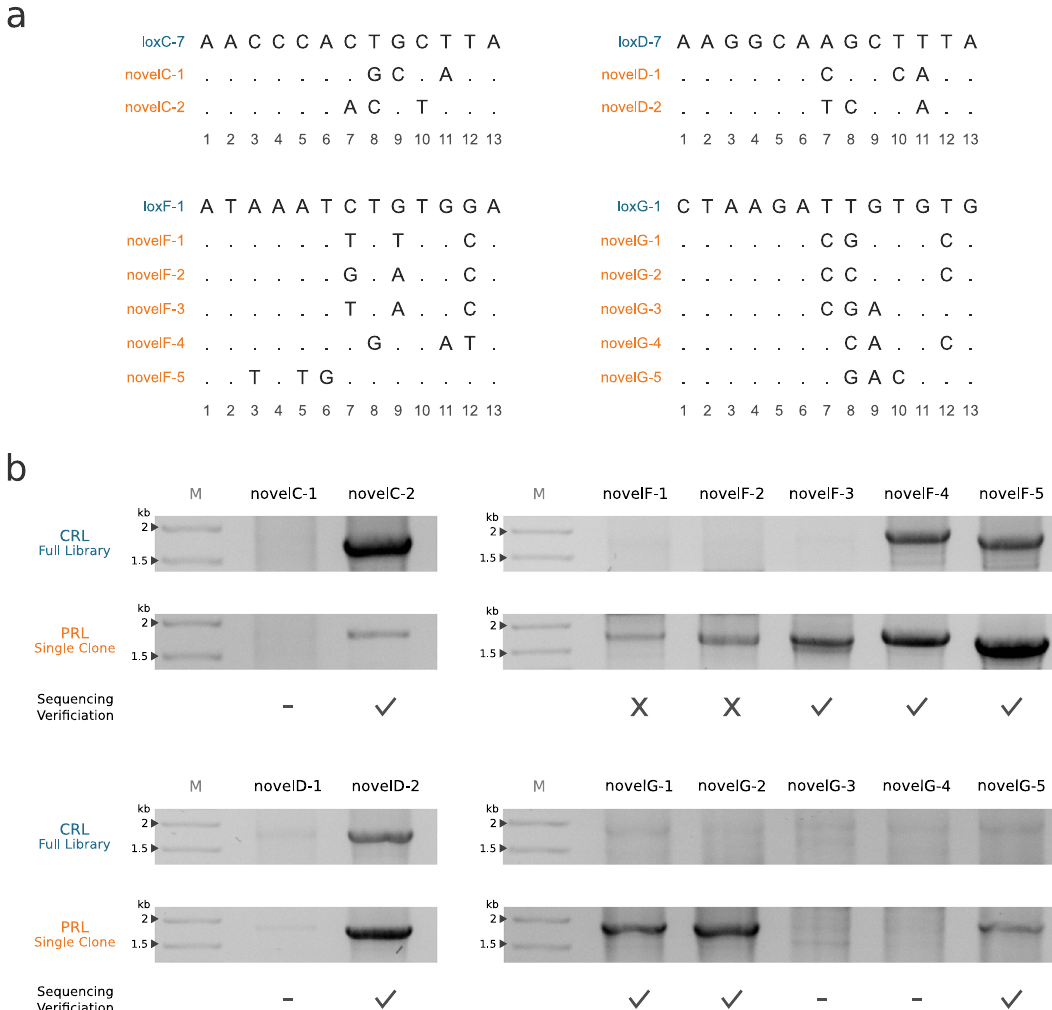
Fig. 4 | Experimental validation of predicted recombinases for novel target sites.a Alignmentofhalf-sitesfromnoveltargetsiteswiththeirrespectiveCRLhalf- sites. Conserved bases are shown with a “ . ” . b PCR-based recombination assay of predicted recombinase clones (PRL single clone) and their respective CRL. Check marksindicatethatthePCRproductscontainedtheeditedsequence,whilecrosses